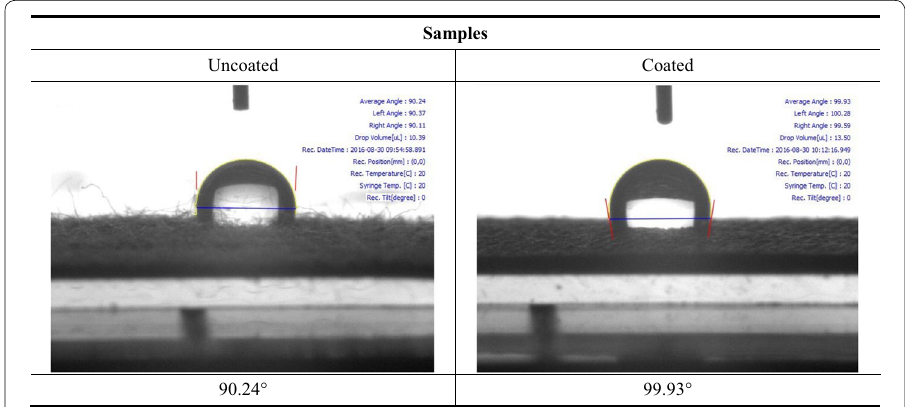
Fig. 6 Contact angle images of CNF/PVDF-HFP composite coated cotton